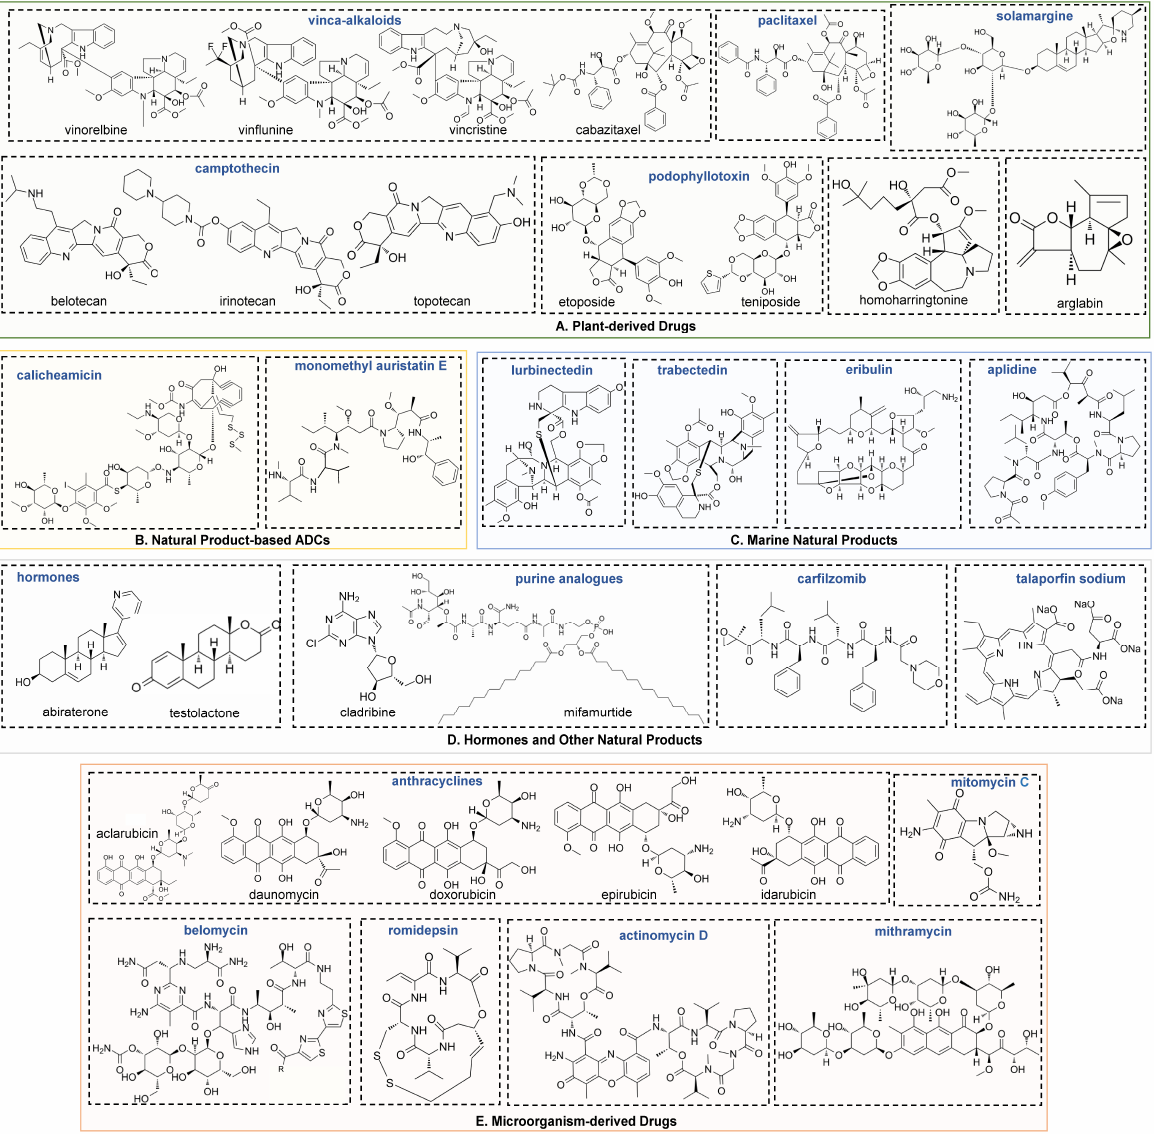
Figure 2. Chemical structures for plant-derived ( A ), ADCs ( B ), marine ( C ), hormones and other natural products ( D ) and microorganism-derived natural products ( E ) .